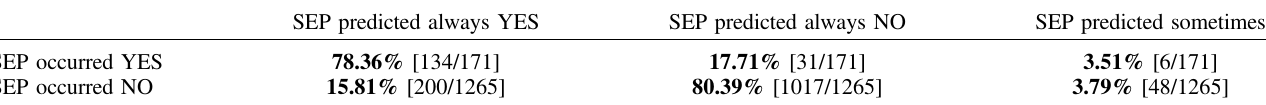
Table 3. Results from the leave-one-out k -fold validation process for solar fl are class (cid:1)